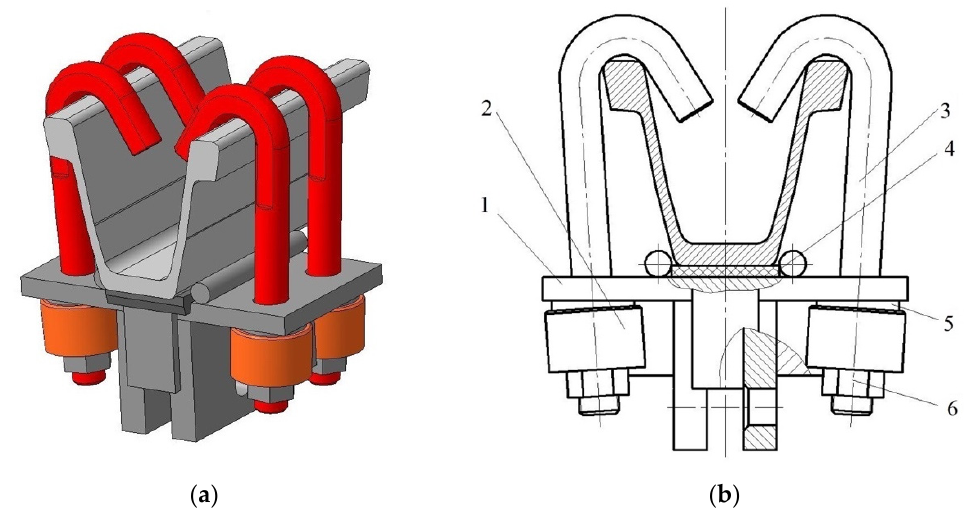
Figure 6. Suspension for monorail track: ( a ) general view; ( b ) schematic diagram, where: 1—case; 2—elastic damping device; 3—fastening bolt; 4—damping insert; 5—taper washer; 6—nut.